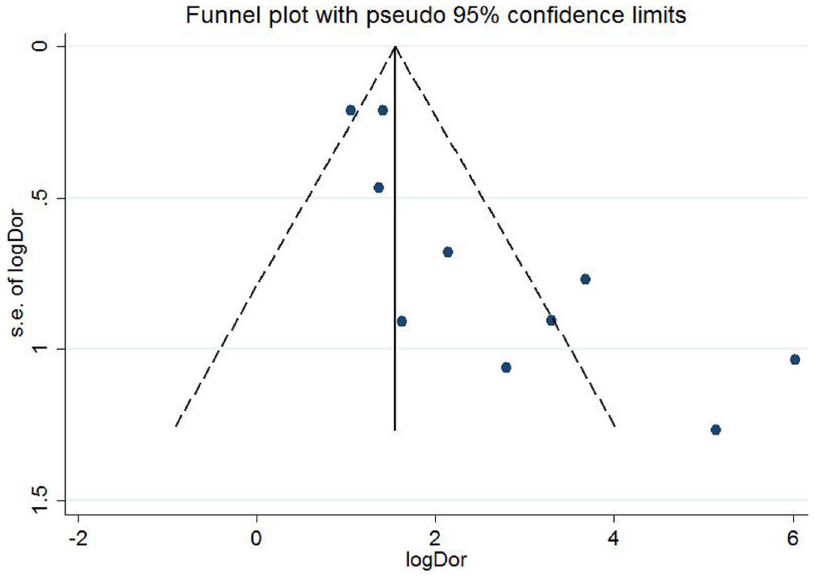
Figure 5. Funnel plot for the evaluation of potential publication bias in diagnosis of KIM-1 for AKI.